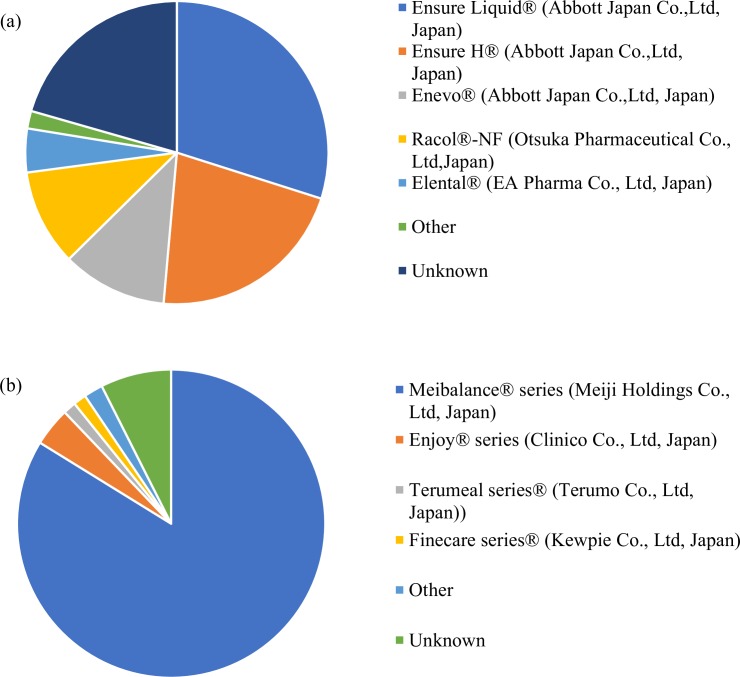
ONS types: (a) prescription ONS (n = 107). (b) over-the-counter ONS (n = 148).